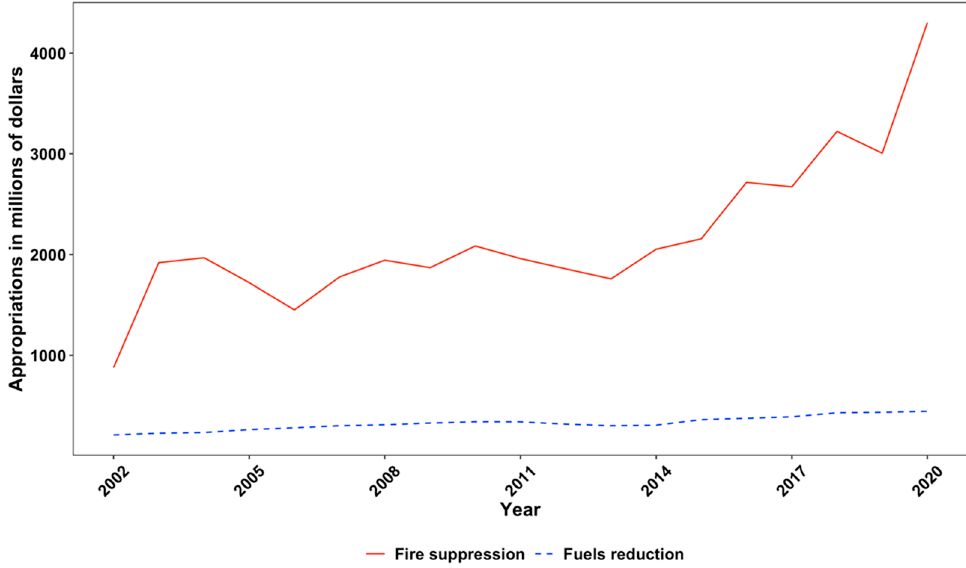
Figure 5. United States Forest Service fire suppression (in red) and fuels reduction (in blue) appropriations 2002–2020, not adjusted for inflation.